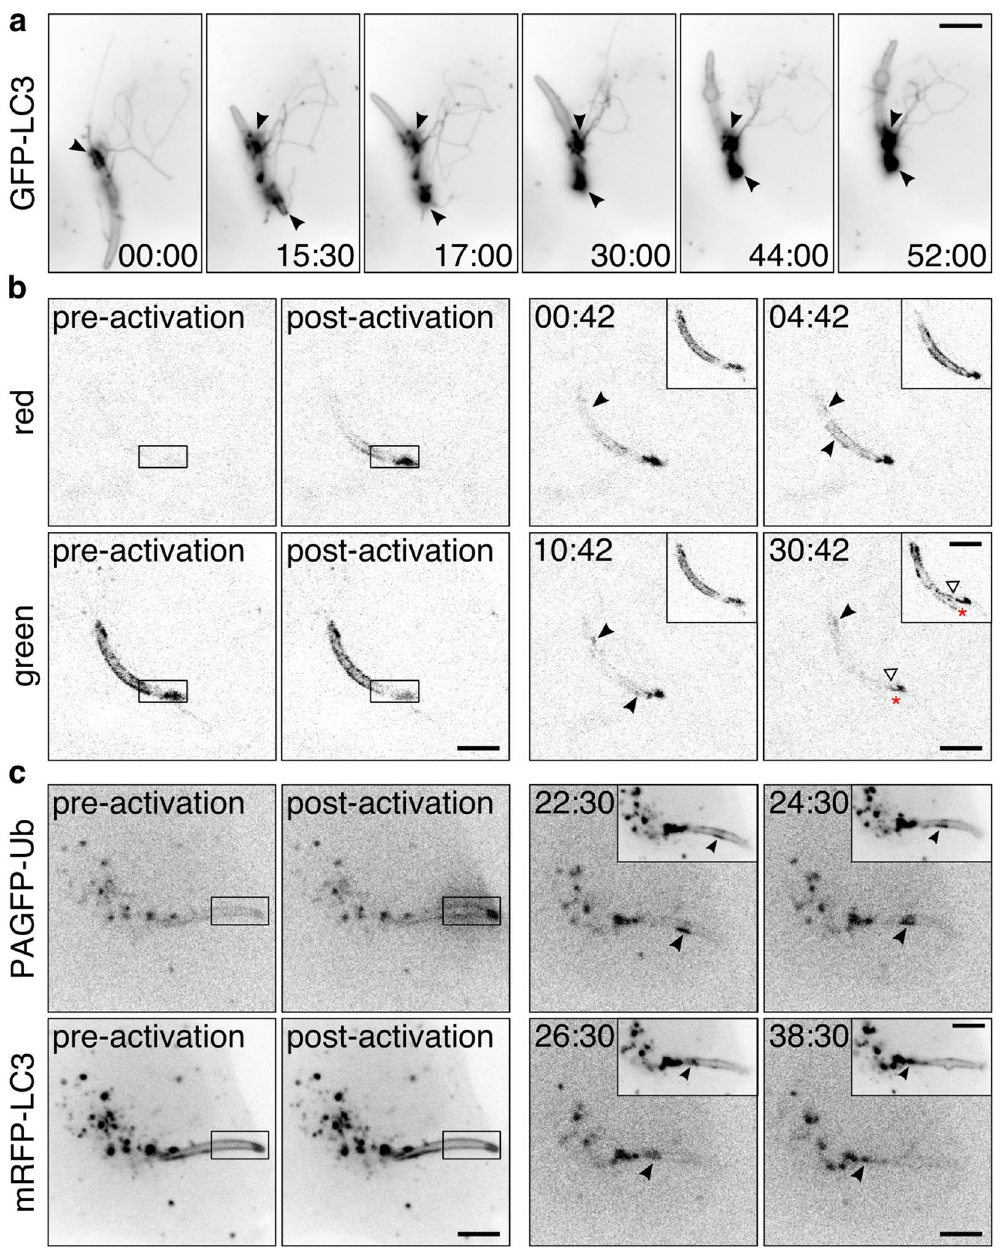
Figure 4. Control of the autophagic components coincides with TVN development. (a) Fast-iterative wide field microscopy of Pb mCherry sporozoites (1 hpi) outlined by parasite-associated LC3. Arrowheads indicate LC3-accumulation in the TVN. Acquisition interval 30 s. (b ) Photoconversion of Dendra2-LC3 at the tip of a Pb wt sporozoite (3 hpi) comprising a nascent TVN. Activated LC3 (black ROI) is tracked at the PVM and accumulates in membrane patches (black arrowhead). White arrowhead points out the accumulation of non- activated LC3 in the TVN. Red asterisk indicates the tip of the sporozoite. Inset displays non-activated LC3 in the green channel. (c) Photoactivation of PAGFP-Ub at the PVM of sporozoites (2 hpi, black ROI) in HeLa cells co-transfected with pmRFP-LC3. Activated ubiquitin (Ub) and LC3 share patches and relocate together from the anterior tip into the posterior TVN-accumulation (black arrowhead). Insets display mRFP-LC3. Time stamps, min:s. Scale bars, 5 µ